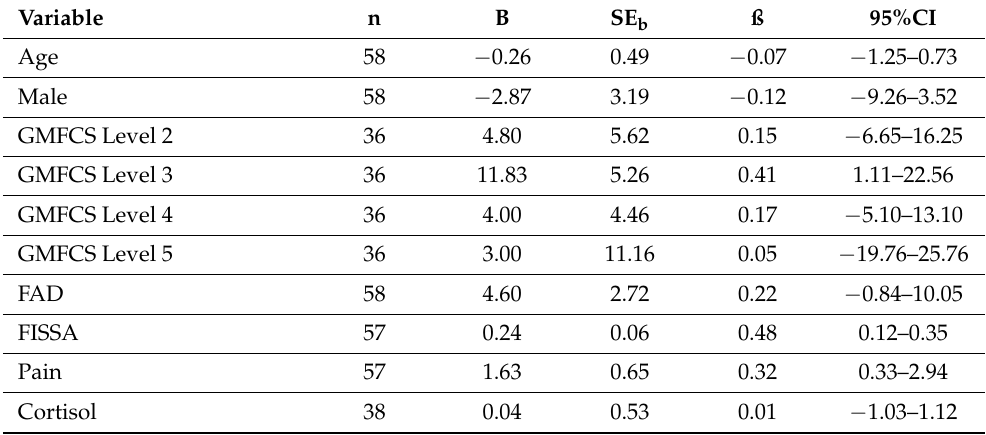
Table 6. Summary of regression models—predictors of S-Anxiety scores.